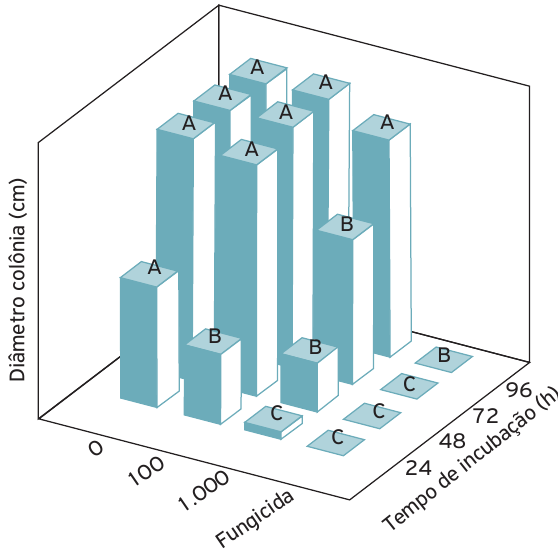
Figura 2. Diâmetro (cm) da colônia de S. sclerotiorum em meio